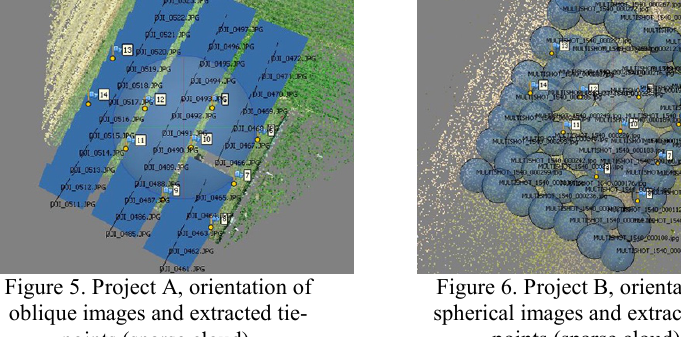
Figure 7. Project C, orientation of spherical and oblique images and extracted tie-points (sparse cloud).